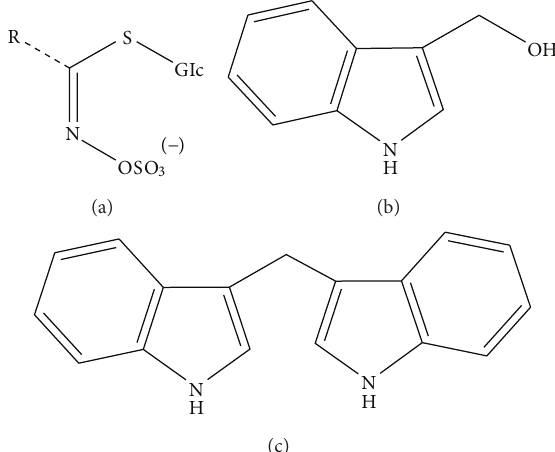
Figure 1: Structures of (a) glucosinolates, (b) I3C, and (c) DIM.